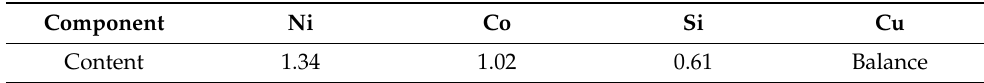
Table 1. Main chemical composition of a Cu-Ni-Co-Si alloy (wt.%). Component Ni Content